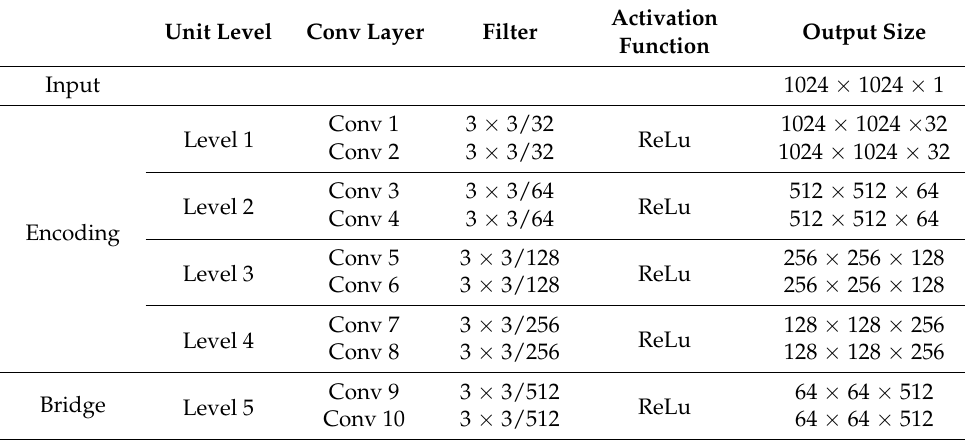
Table 1. U-Net architecture and hyperparameters.